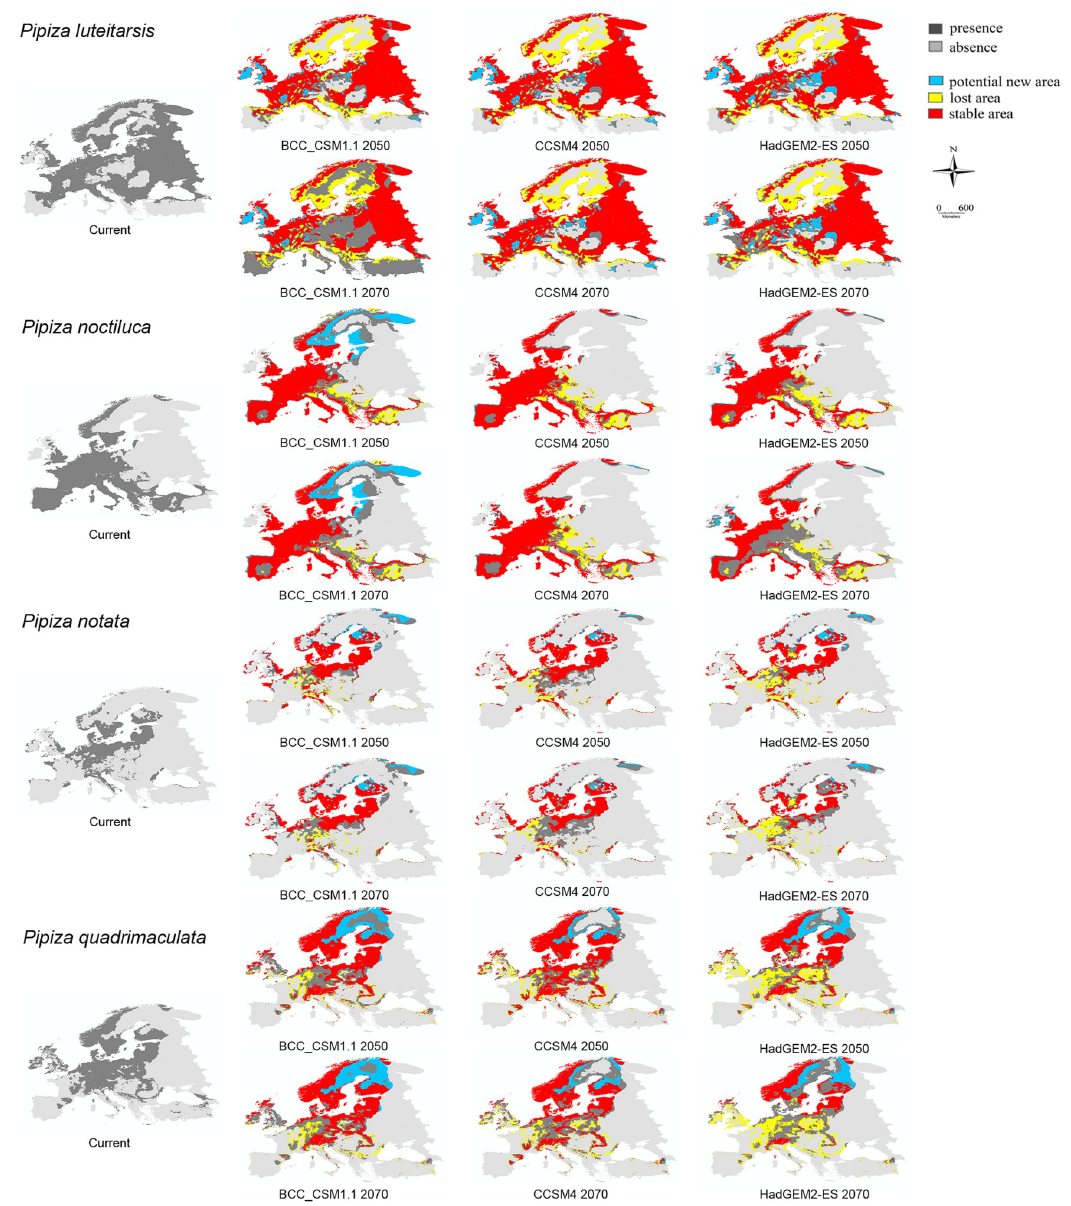
Fig 3. Modelled species distributions under current climate and future climatic models and all scenarios for: P . luteitarsis , P . noctiluca , P . notata , P . quadrimaculata